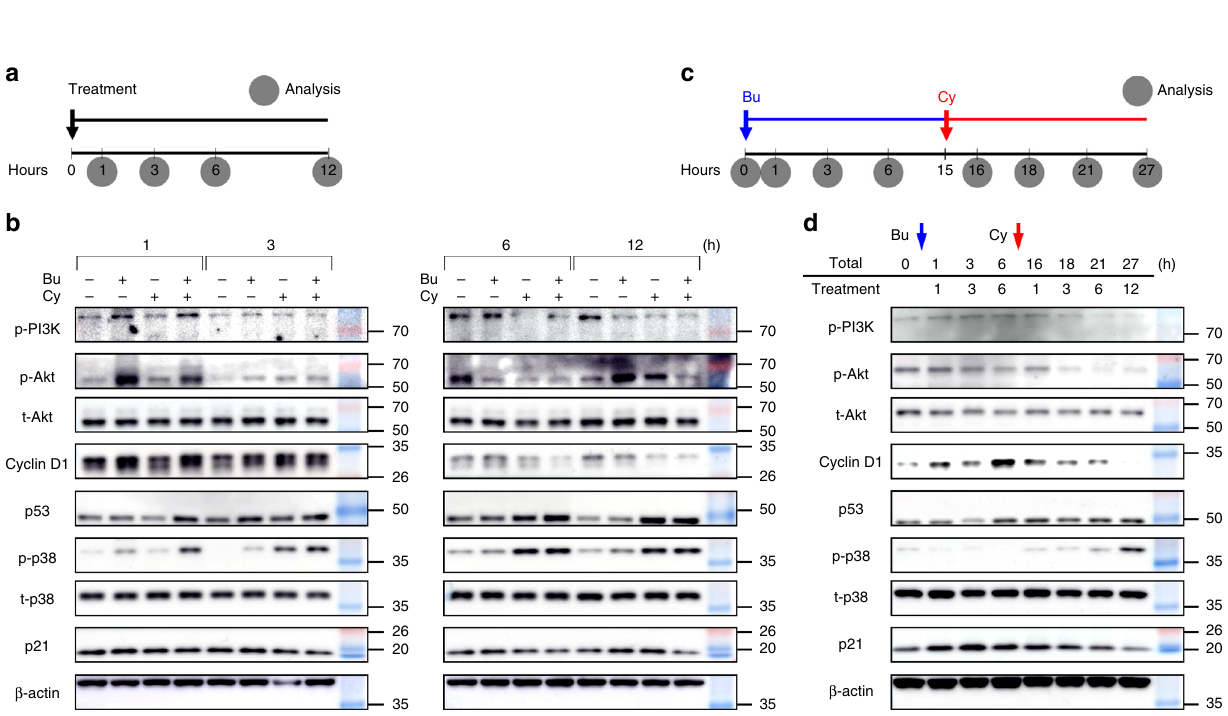
Fig. 5 Cellular response to alkylating agents depending on proliferation status. a Schedule for single or combined treatment with alkylating agents and subsequent cell cycle analysis of actively growing and con fl uent quiescent ORS cells after 24 h of treatment. b Representative fl ow cytometry plots with propidium iodide staining and quanti fi cation of cell cycle analysis measured as the percentage of the total cell population of actively growing or con fl uent quiescent ORS cells ( n = 4 biological replicates). Note that the Bu treatment reduced the S phase subset in growing cells but induced the S phase subset in quiescent cells. c Schedule for sequential treatment with alkylating agents and subsequent cell cycle analysis of con fl uent quiescent ORS cells after 15 plus 24 h of treatment. d Representative fl ow cytometry plots with propidium iodide staining and quanti fi cation of cell cycle analysis measured as the percentage of the total cell population of con fl uent quiescent ORS cells ( n = 6 biological replicates), cell count and cell debris ( n = 3 biological replicates). The initial Bu treatment forced the transition of quiescent cells into the S phase, and the subsequent Cy treatment eradicated these DNA-replicating cells, resulting in reduced total cell counts and increased cell debris. Bu busulfan, Cy cyclophosphamide, BuCy busulfan combined with cyclophosphamide, Bu/Cy busulfan followed by cyclophosphamide. Data are mean ± SEM. Source data are provided as a Source Data fi le. * p < 0.05 (vs. Con); ** p < 0.01 (vs. Con);